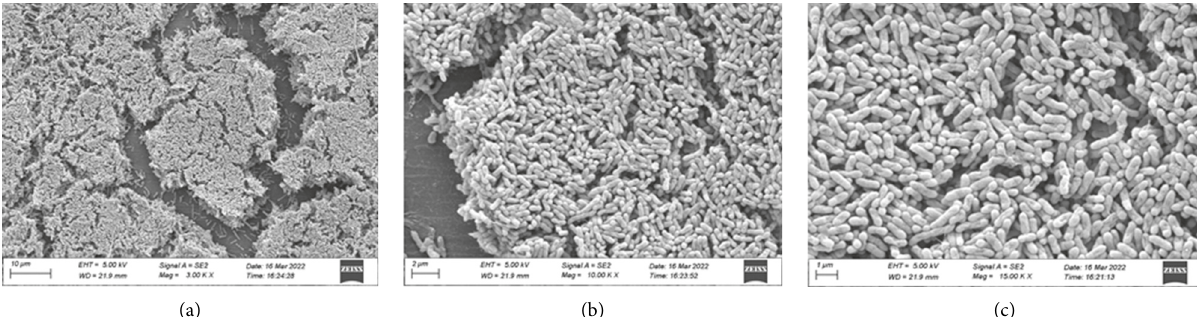
Figure 4: Scanning electron microscopic (SEM) images of the biofilm of the representative Salmonella typhimurium strain SP6 formed at 4%(a; b; c) salt concentration. Magnification: (a) 3000x, (b) 10000x, and (c) 15000x; inset bar is representative of (a) 10 μ m, (b) 2 μ m, and (c) 1 μ